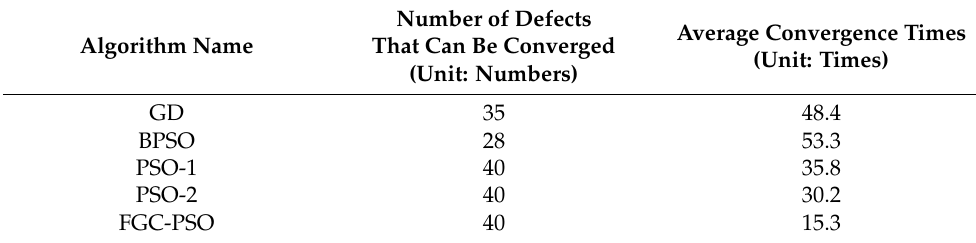
Table 2. Convergence statistical results of 40 defects with 10 DOFs.